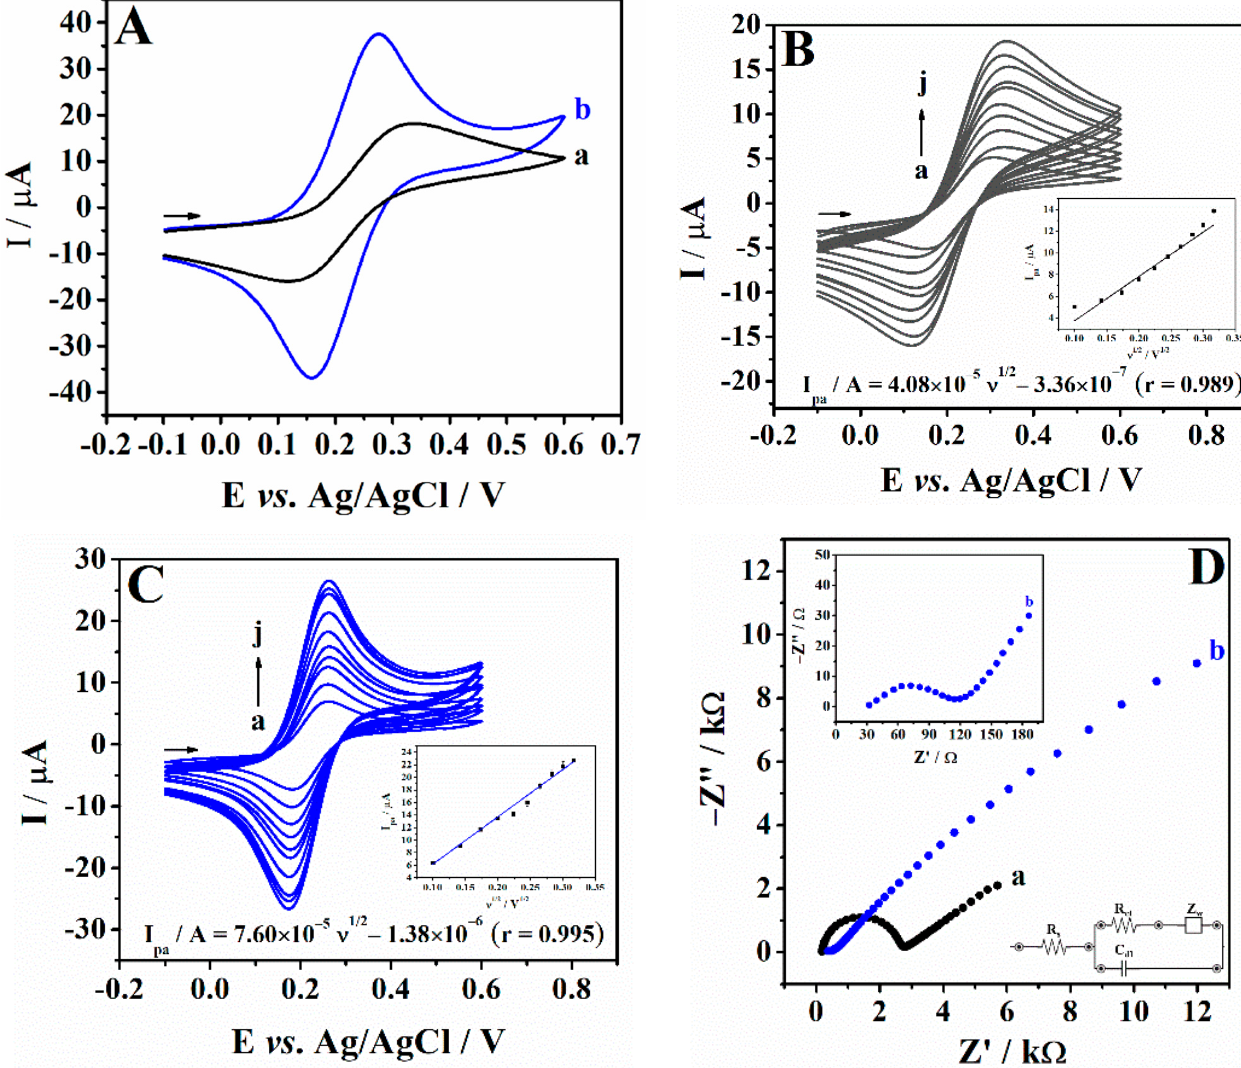
Figure 2. ( A ) Cyclic voltammograms of 5.0 mmol L − 1 K 4 [Fe(CN 6 )] in 0.1 mol L − 1 KCl at (a) the CPE and (b) PEI/CPE ( ν = 100 mV s − 1 ). Cyclic voltammograms for 5.0 mmol L − 1 K 4 [Fe(CN 6 )] in 0.1 mol L − 1 KCl at ( B ) the CPE and ( C ) PEI/CPE with different scan rate values: (a) 10, (b) 20, (c) 30, (d) 40, (e) 50, (f) 60, (g) 70, (h) 80, (i) 90, and (j) 100 mV s − 1 . Inserted: plot of I pa vs. ν 1 2 . ( D ) Nyquist plots for 5.0 mmol L − 1 equimolar mixture of K 3 [Fe(CN) 6 ]/K 4 [Fe(CN) 6 ] in 0.1 mol L − 1 KCl at (a) the CPE and (b) PEI/CPE. Inserted: amplification of diagram obtained in the PEI/CPE and the Randles circuit. R s : solution resistance; R ct : charge transfer resistance; Z w : Warburg